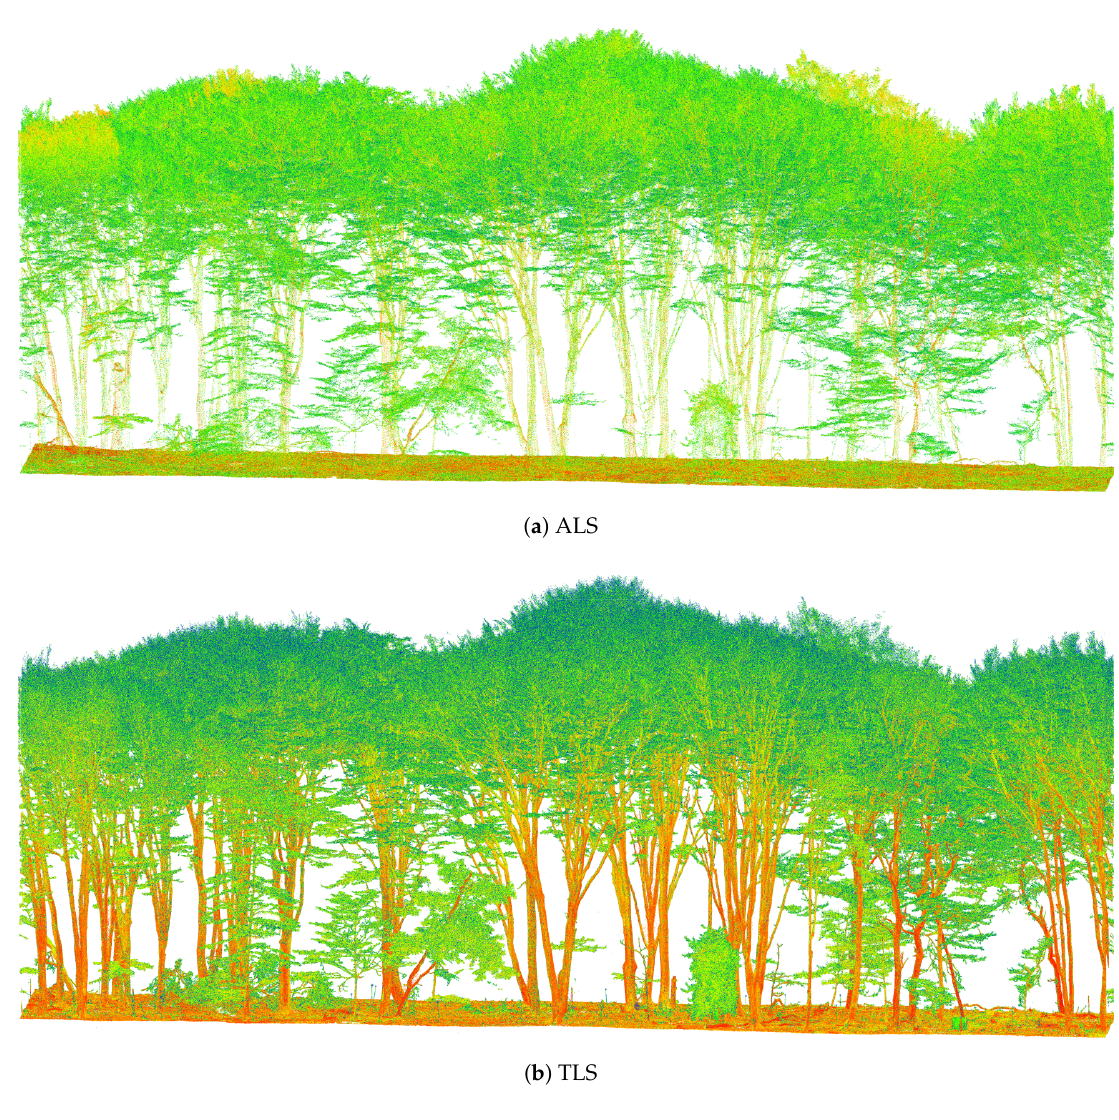
Figure 3. Old Beech and Oak point clouds samples from same perspective, coloured according to apparent reflectance (blue = low, green = medium, red